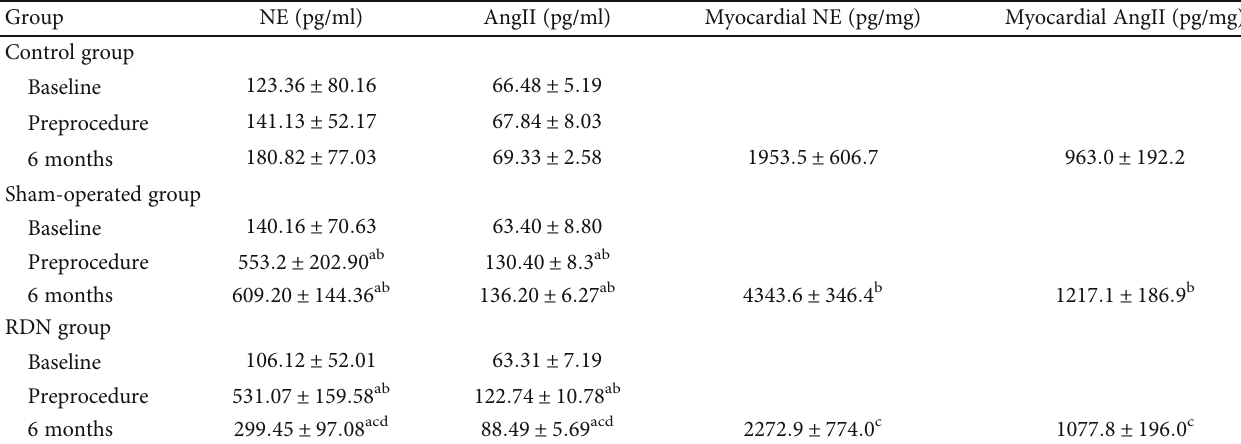
Table 2: Changes in levels of norepinephrine (NE) and angiotensin II (AngII) in experimental dogs (control group ( n = 20 ), sham-operated group ( n = 19 ), and RDN group ( n = 19, (cid:1) x ± S )).